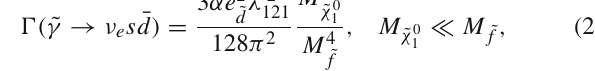
Fig. 8 Branching ratios of the stau four-body decay ˜ τ → τμ jj as a function of A 0 and tan β using λ (cid:4) λ (cid:4) | = 0 . 07 (right). The other parameter values are M M X 222